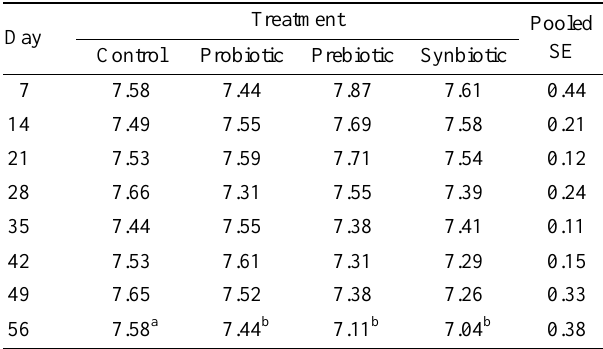
a,b Value with different Superscripts within a row differ significantly (p<0.05).